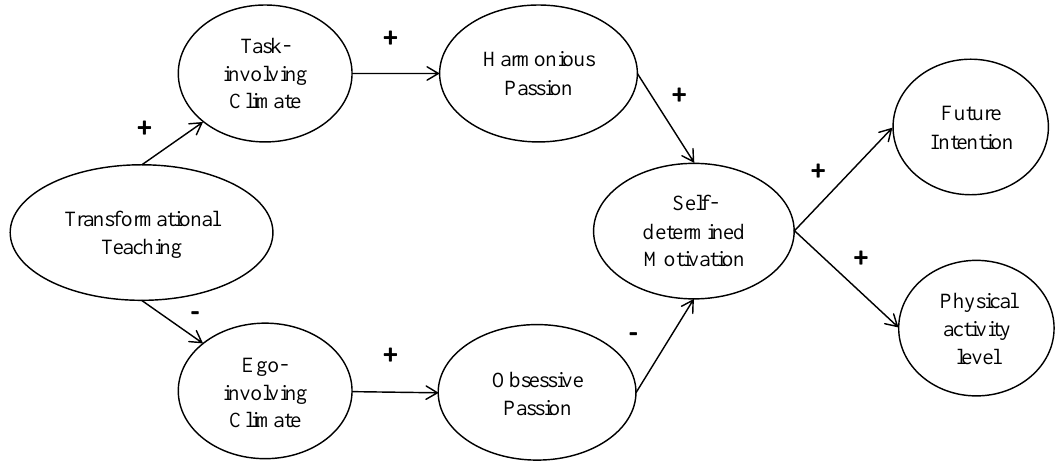
Figure 1. The hypothesized model of the interrelationships between PE students’ perceptions of the social environment, passion, self-determined motivation, future intention, and physical activity level.